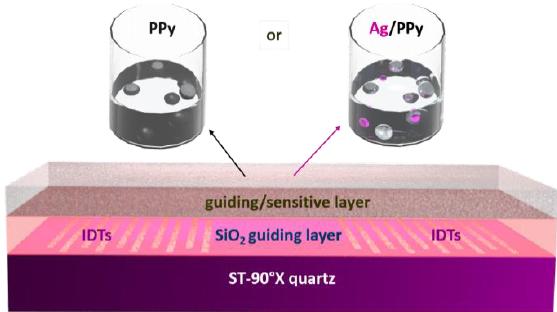
Figure 1. Schematic view of a L-SAW sensor and solutions used for deposition of PPy or Ag/PPy guiding/sensitive layers.